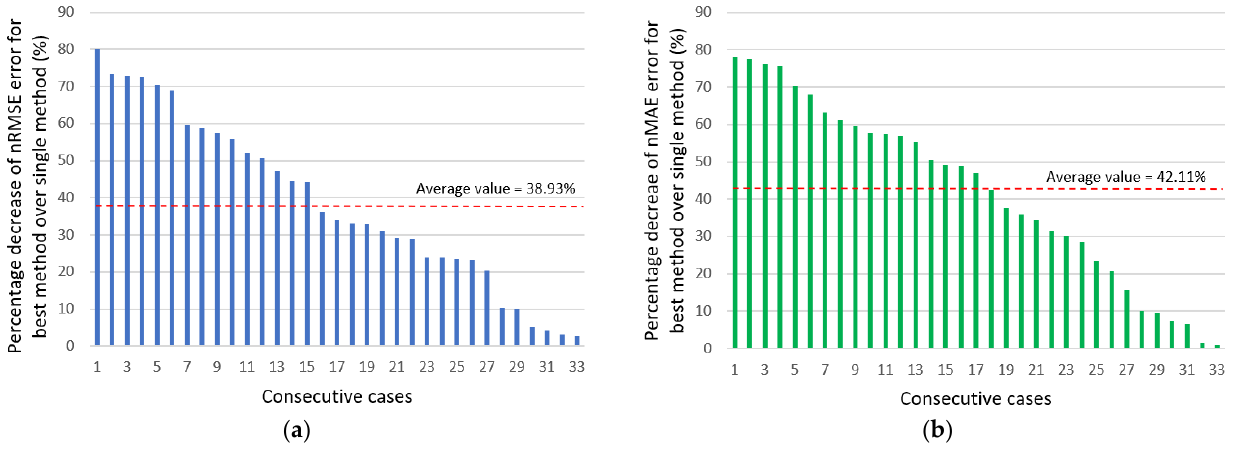
Figure 15. ( a ) Percentage reduction in nRMSE for the best method relative to the single method; ( b ) percentage reduction in nMAE for the best method relative to the single method.